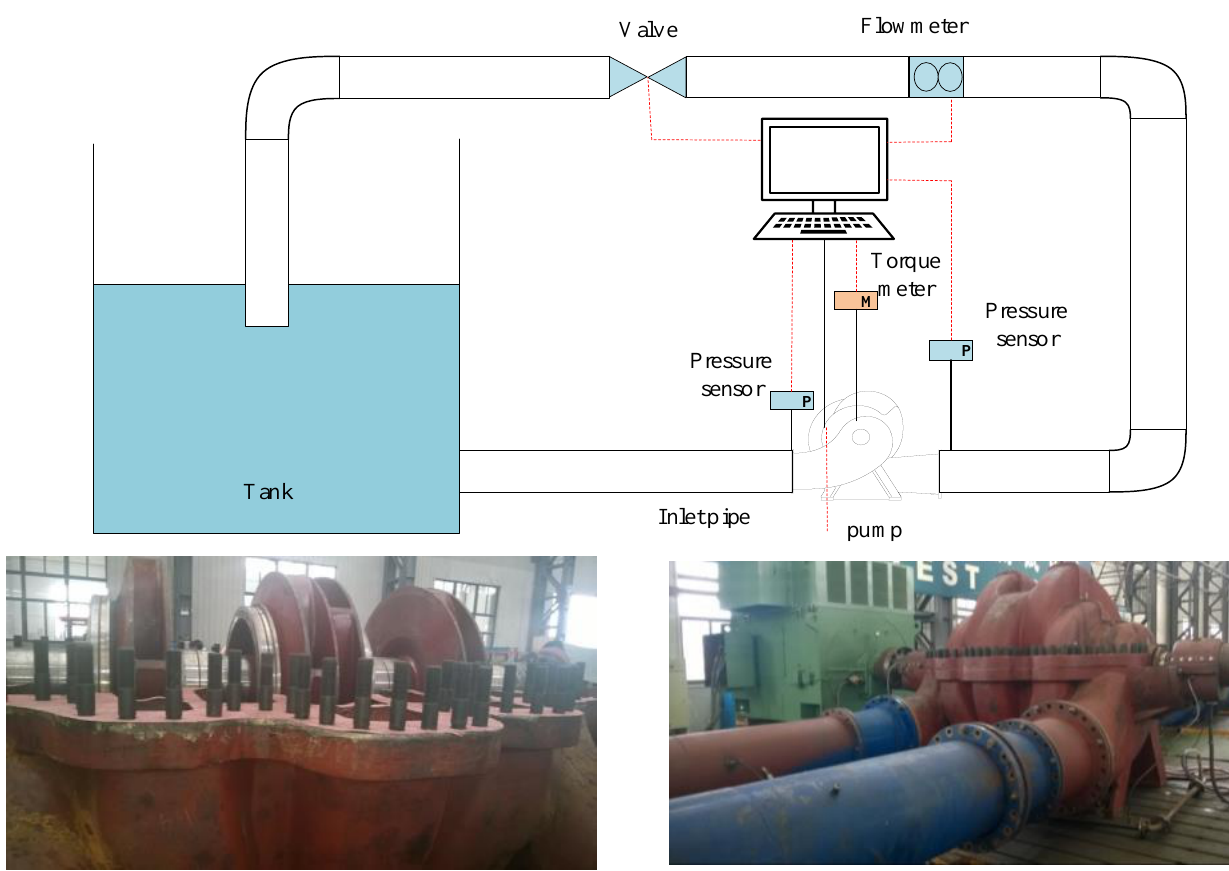
Figure 6. Test rig.